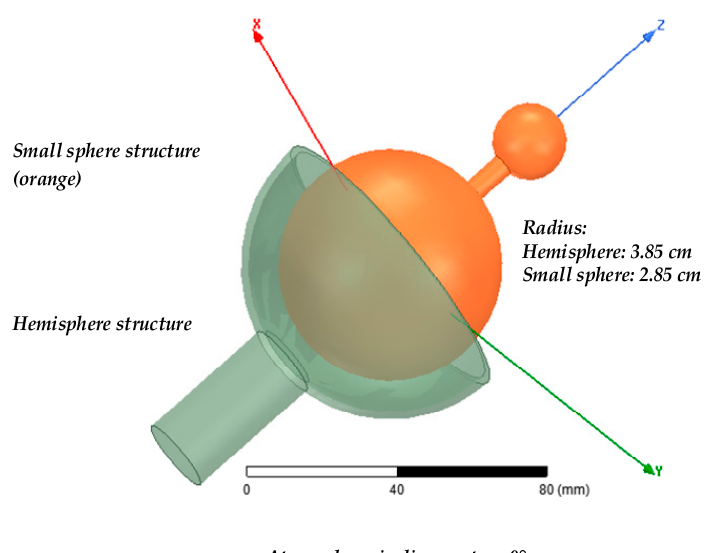
Figure 3. Modeling of the spherical-joint system: ( a ) spherical structure with small sphere (orange) and large sphere; ( b ) view of the joint system under different angular misalignment α (0–85°); ( c ) dimensions of the studied joint structure.